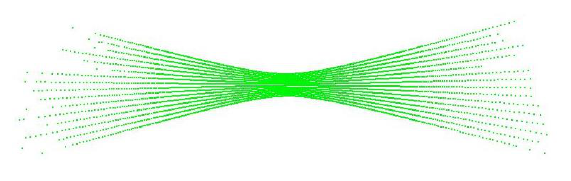
Figure 9. Footprint over the flat area